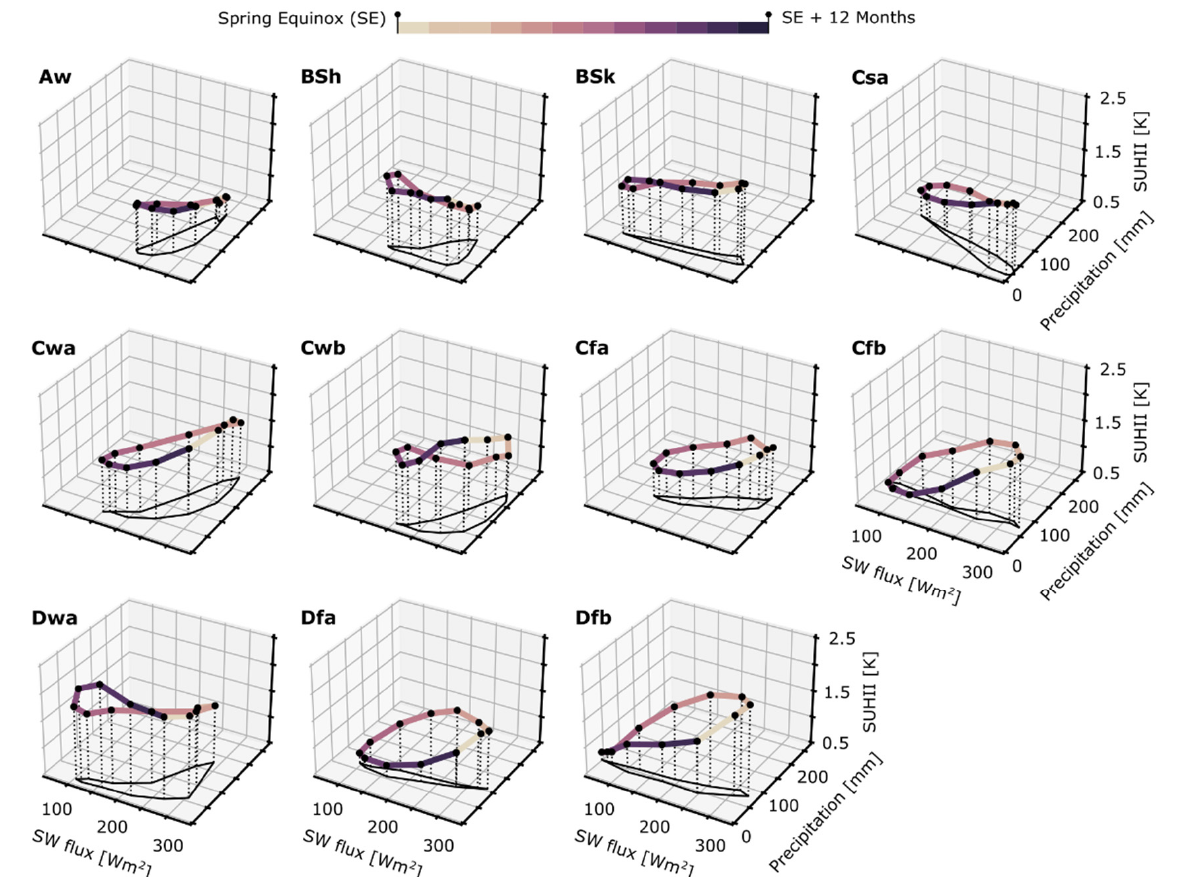
Figure 7. The seasonal variation of precipitation, clear-sky at-surface downwelling shortwave radiation flux (SW) and nighttime SUHII for each Köppen–Geiger climate class examined in this work. Each dot represents a month (the start and end points correspond to spring equinox). The monthly means refer to the years 2000–2018, and the color of the line indicates the direction of each loop.